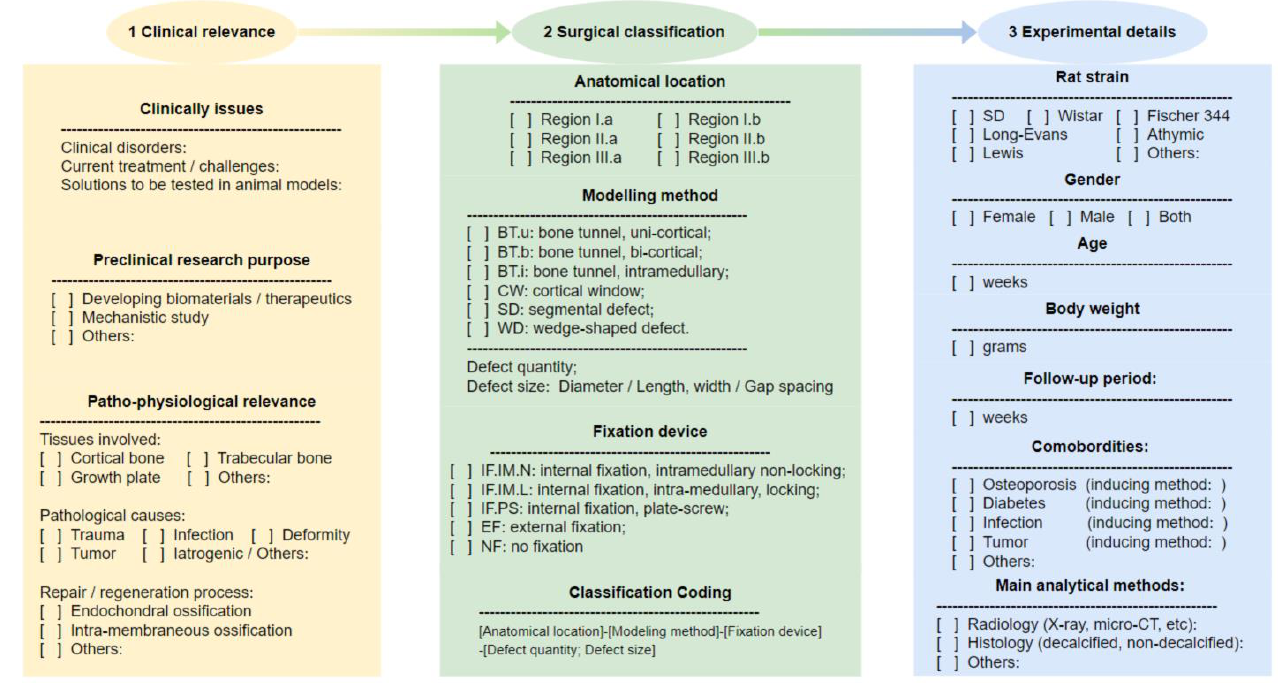
Figure 10. Application pipeline involving the surgical classification system for experimental planning.